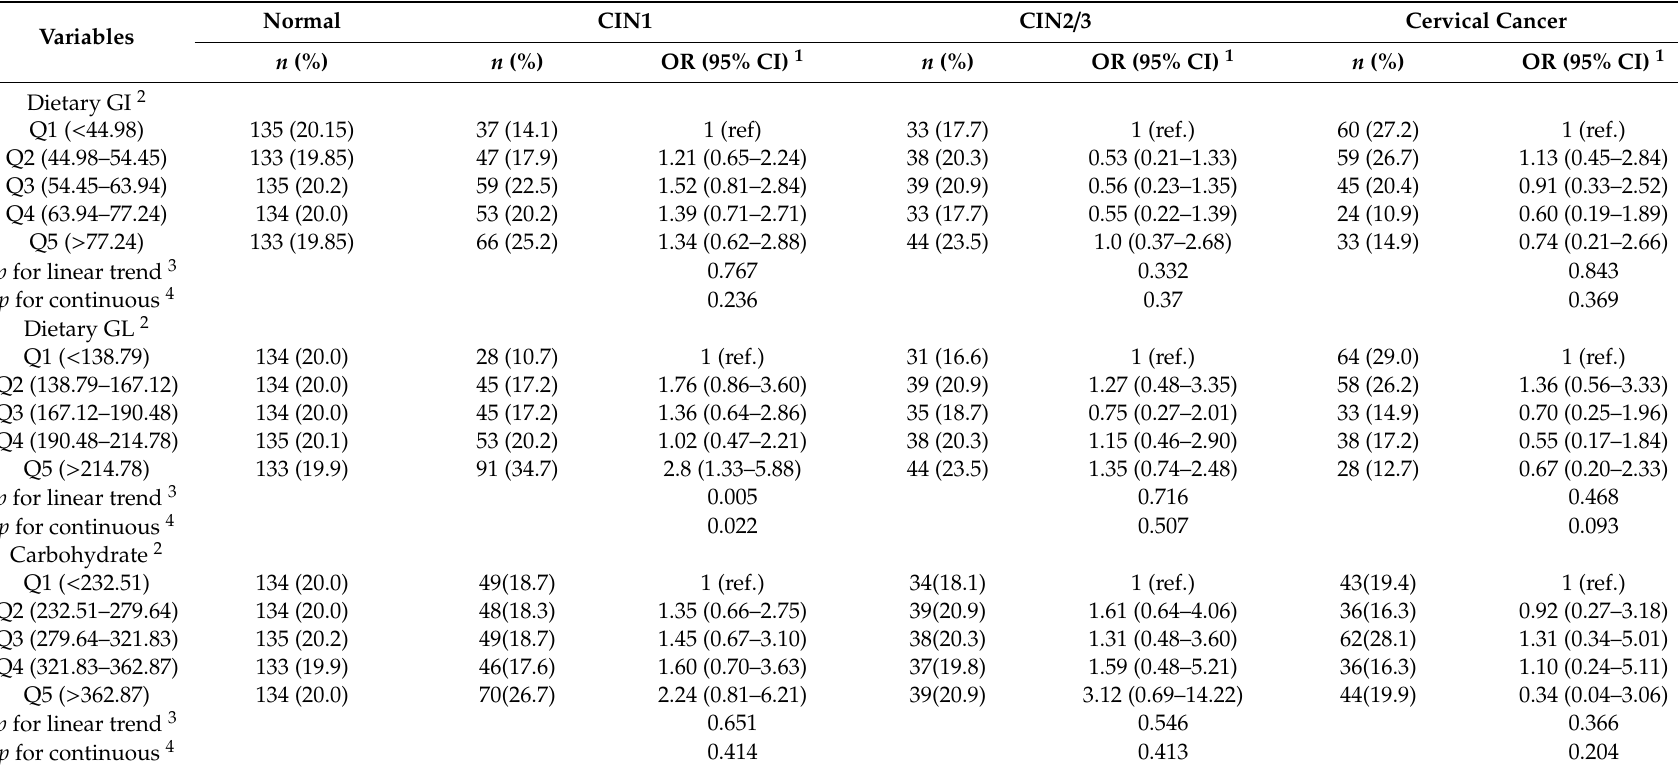
Table 2. Multivariate ORs of dietary glycemic index (GI) and glycemic load (GL) for the risk of CIN and cervical